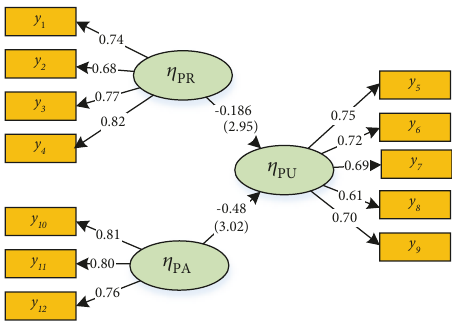
Figure 4: MIMIC submodel for service counters.